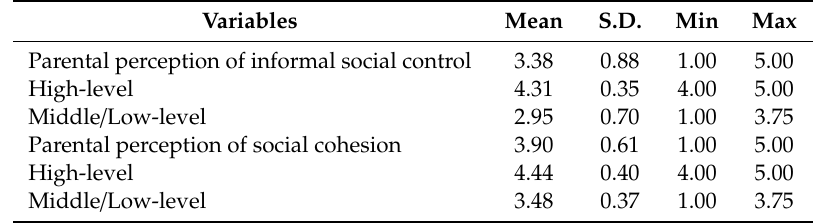
Table 2. Descriptive statistics for variable of parental perception of neighborhood collective e ffi